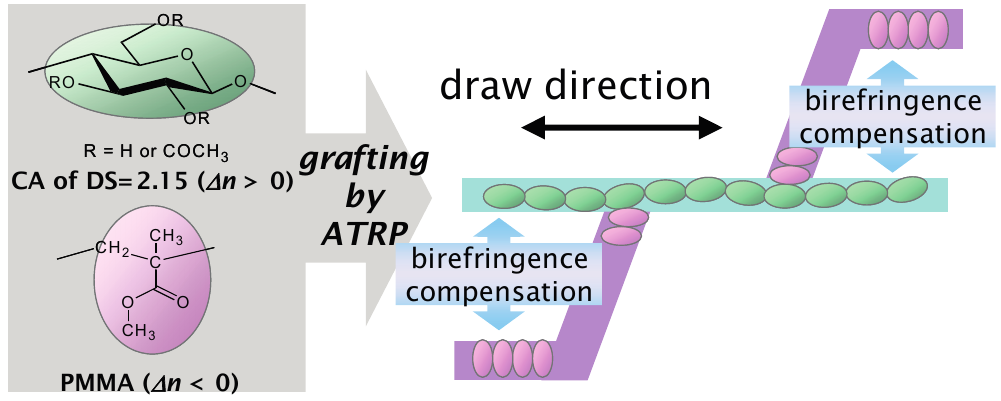
Figure 33. Schematic representation of orientational birefringence in CA- g -PMMA. Reproduced with permission from ref. [73]. Copyright 2013 American Chemical